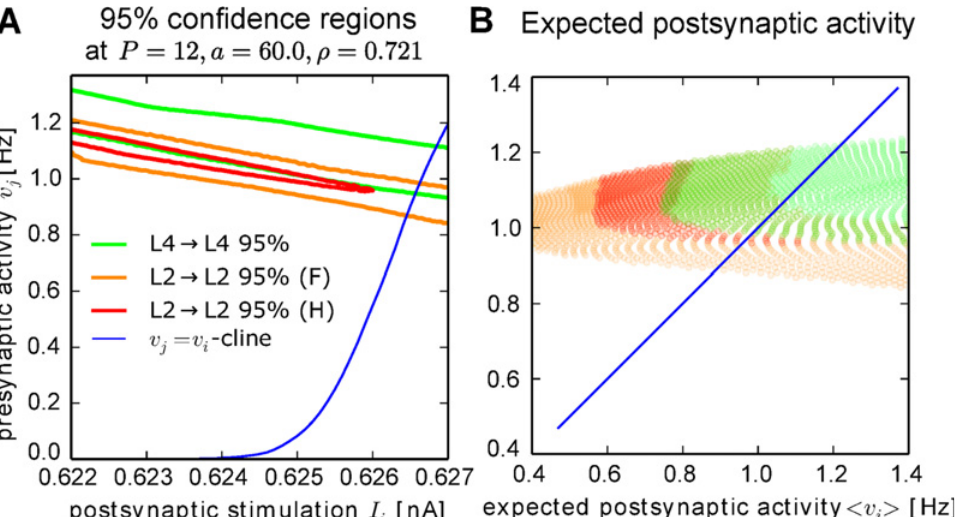
Figure 6. Quantitative estimates of the activities show biological reasonable ordering in a reasonable frequency regime. (A) Activity confidence regions for intra-layer connections in somatosensory cortex. To obtain quantitative results, we used an input-output-relation (blue line) from an adaptive exponential integrate-and-fire neuron [54] and a calcium-based plasticity rule [24] (see Methods). As in Fig. 5, the activities for layer IV connections are larger than those for layer II connections. The firing frequencies lie in a biological reasonable range. (B) The expectation value of the postsynaptic activity for stimulations within the confidence intervals confirm that experimental data can be reproduced with equal pre- and postsynaptic activity as expected for intra- layer